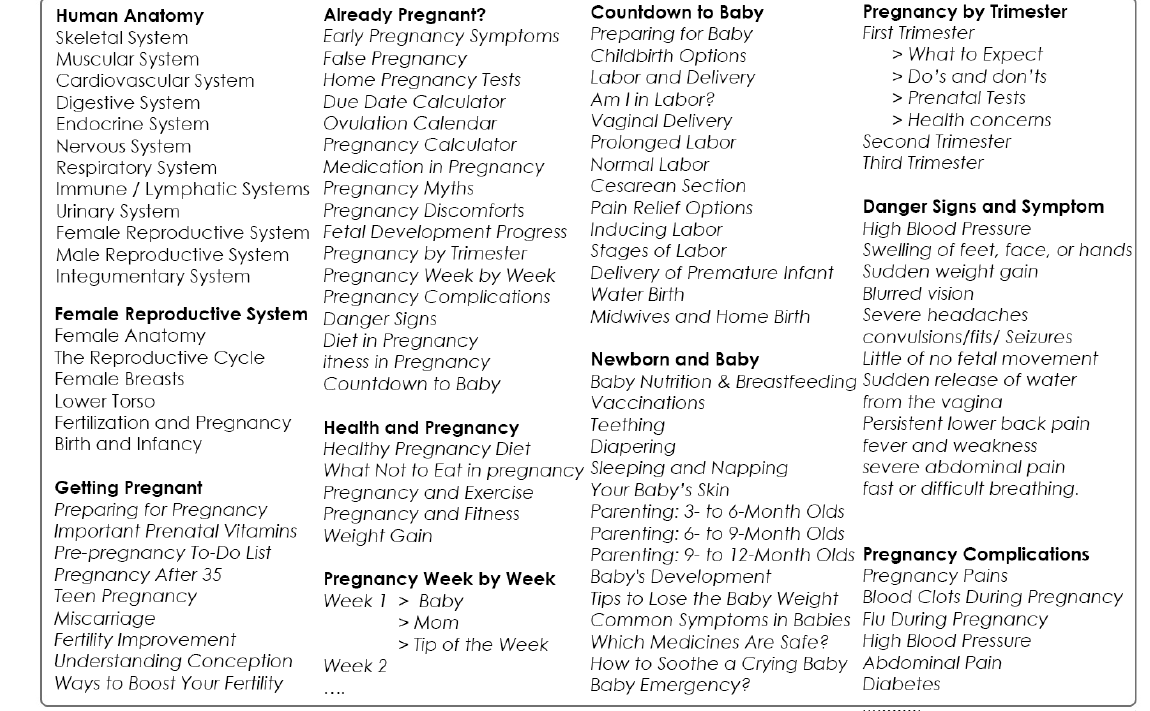
Figure 2. Proposed contents for the Pregnancy Care Network